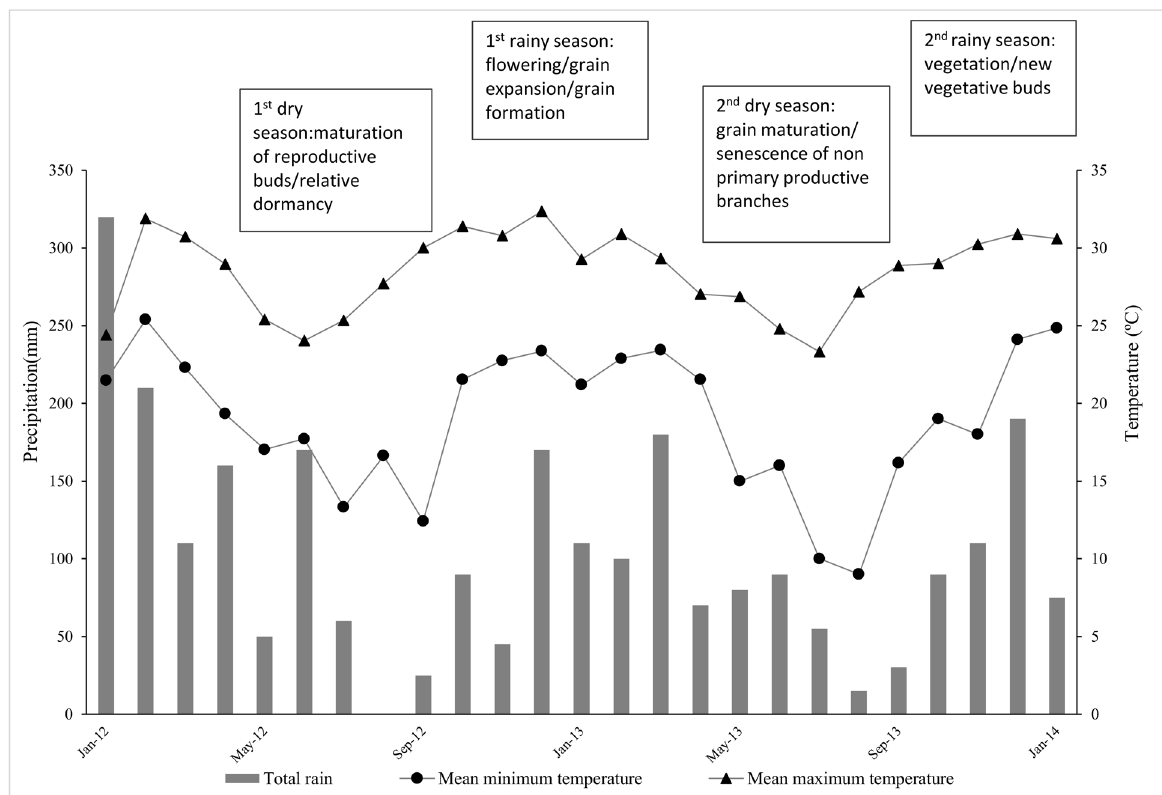
Figure 1. Monthly minimum and maximum mean air temperatures, rainfall distribution and phenological stage of coffee plants in FACE